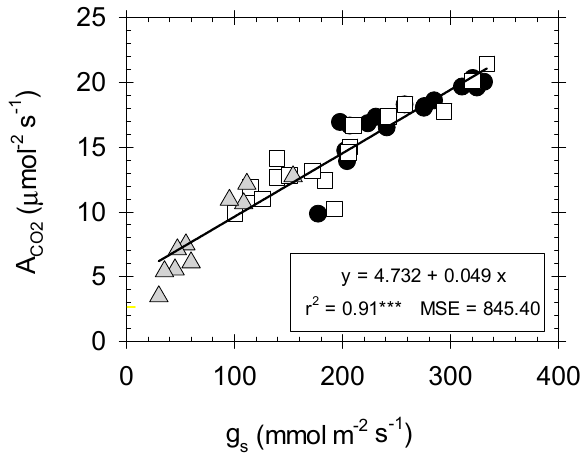
Figure 3. Relationship between stomatal conductance (g s , mmol m − 2 s − 1 ) and net CO 2 assimilation rate (A CO2 , µmol m − 2 s − 1 ) in the different irrigation treatments: T–C ( ● ), T–M ( □ ), and T–S ( ). Each point is the mean of four leaves. Coefficient of determination for T–C (r 2 = 0.71***), T–M (r 2 = 0.83***), and T– (r 2 = 0.96***). ***: p ≤ 0.001, MSE: mean squared